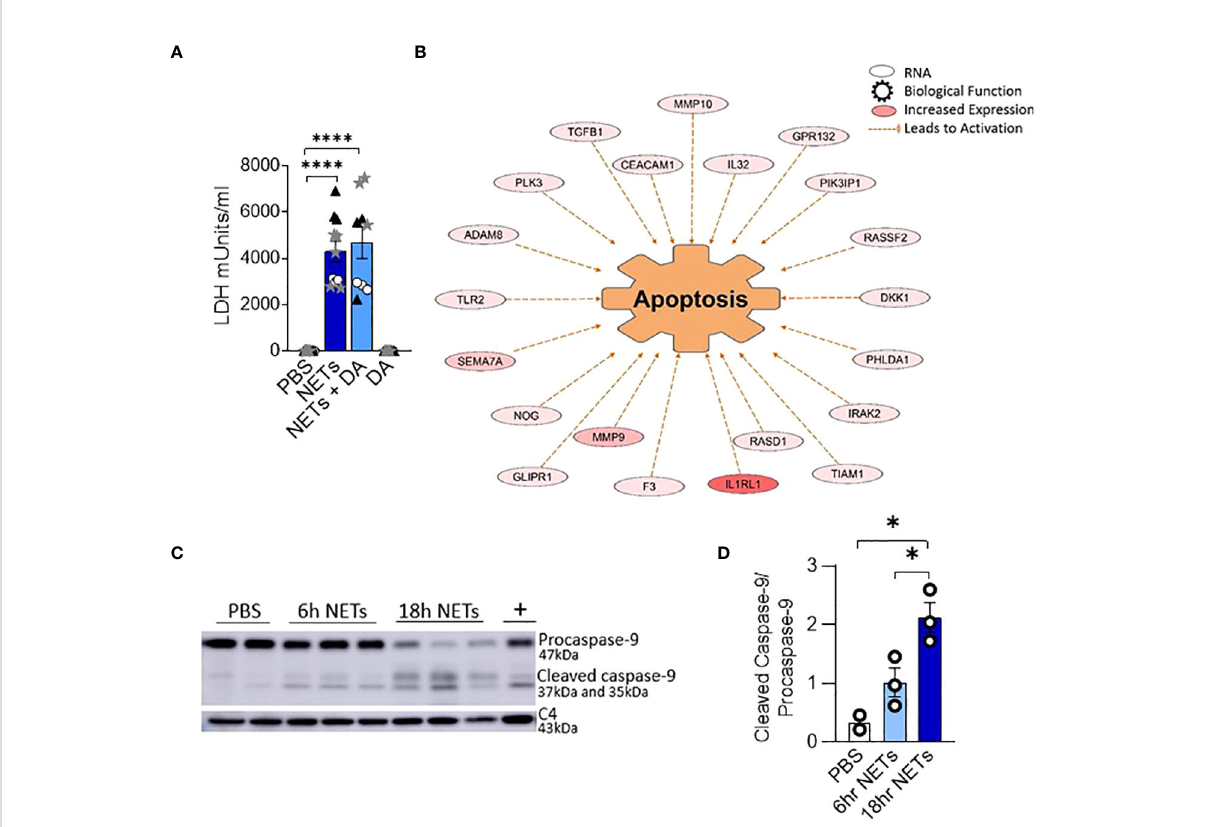
FIGURE 2 NETs activate apoptosis in normal human bronchial epithelia. HBE were grown at ALI and exposed to PBS control, 5µg/ml NETs, NETs+0.5µg/ ml dornase alpha (DA), or DA in the apical compartment for 18h in triplicate wells. (A) LDH concentration measured in apical supernatant. Data analyzed by one-way ANOVA followed by Bonferroni ’ s multiple comparisons test (experiments=2, HBE donors=2, NET donors=2). (B) Differential gene expression assessed by RNA sequencing in HBE after exposure to 5µg/ml NETs compared to PBS. Network representation of impacted genes predicted to activate apoptosis. Color intensity indicates increased expression. Data analyzed using Ingenuity Pathway Analysis (IPA) (p=1.07e-13, experiments=3, HBE donors=3, NET donors=3). (C, D) Representative western blot and analysis demonstrate